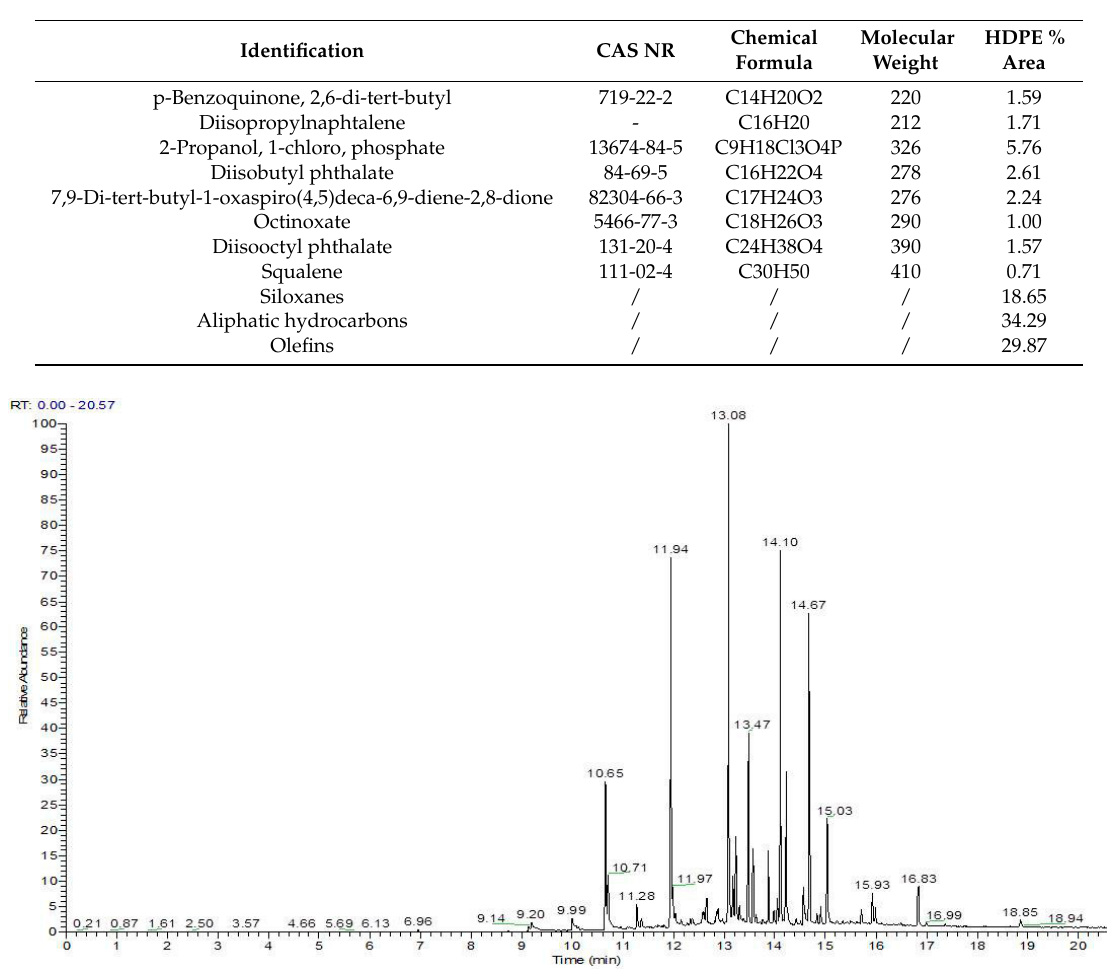
Figure 4. Chromatogram of the head space solid phase microextraction (HS-SPME) extract for containers.